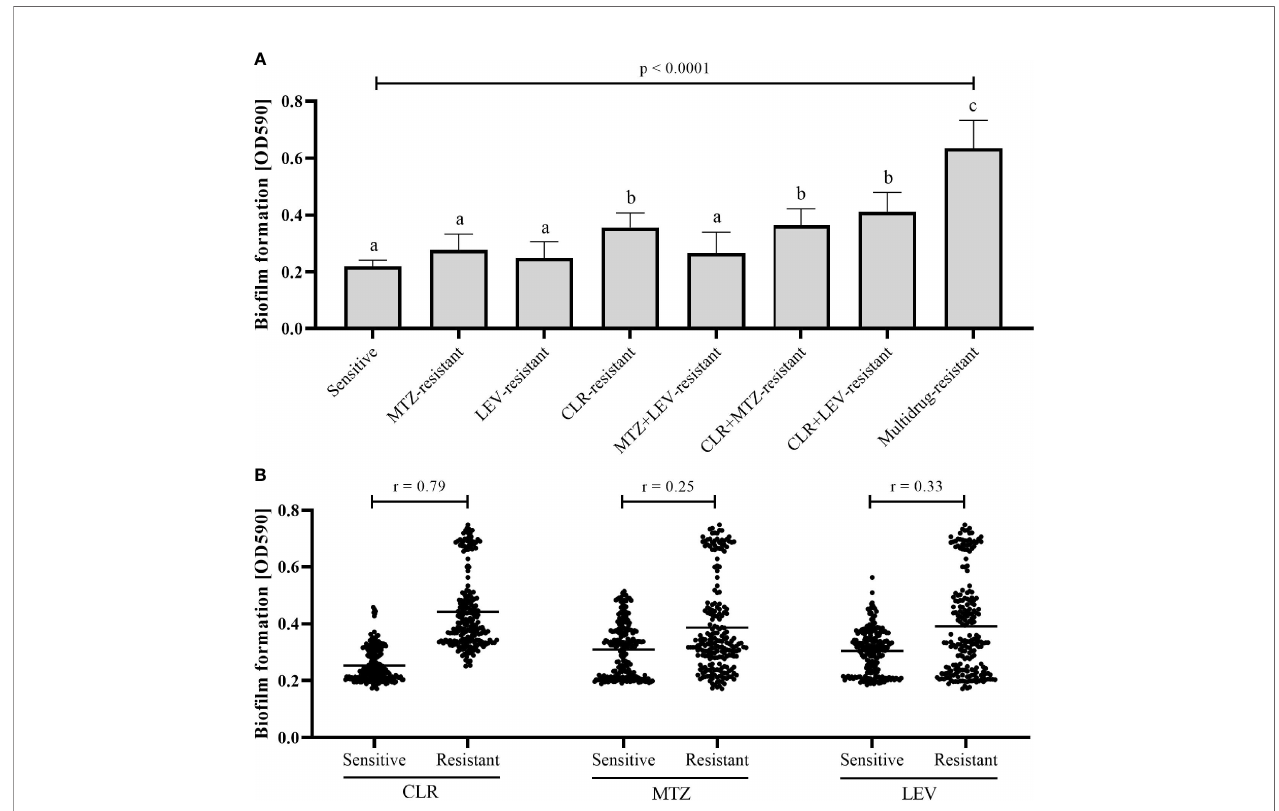
FIGURE 2 | Correlation between the bio fi lm formation capacity of 24 clinical H. pylori strains and their resistance pro fi le (A) or resistance to a speci fi c type of antibiotic (B) . Determination of bio fi lm production was performed in static conditions and a 3-day incubation using a crystal violet staining method. The correlation between the bio fi lm formation and resistance pro fi le (A) was calculated by the Kruskal Wallis test and columns with the same subscript letters (a, b, c) are not signi fi cantly different from each other (p > 0.05). The correlation between the bio fi lm formation and resistance to a speci fi c type of antibiotic (B) was calculated by the Spearman correlation test, where 0 means no dependence and 1 a very strong dependence. The tests were performed in three biological replications with six technical repetitions (n = 18/strain). CLR, clarithromycin; MTZ, metronidazole; LEV, levo fl